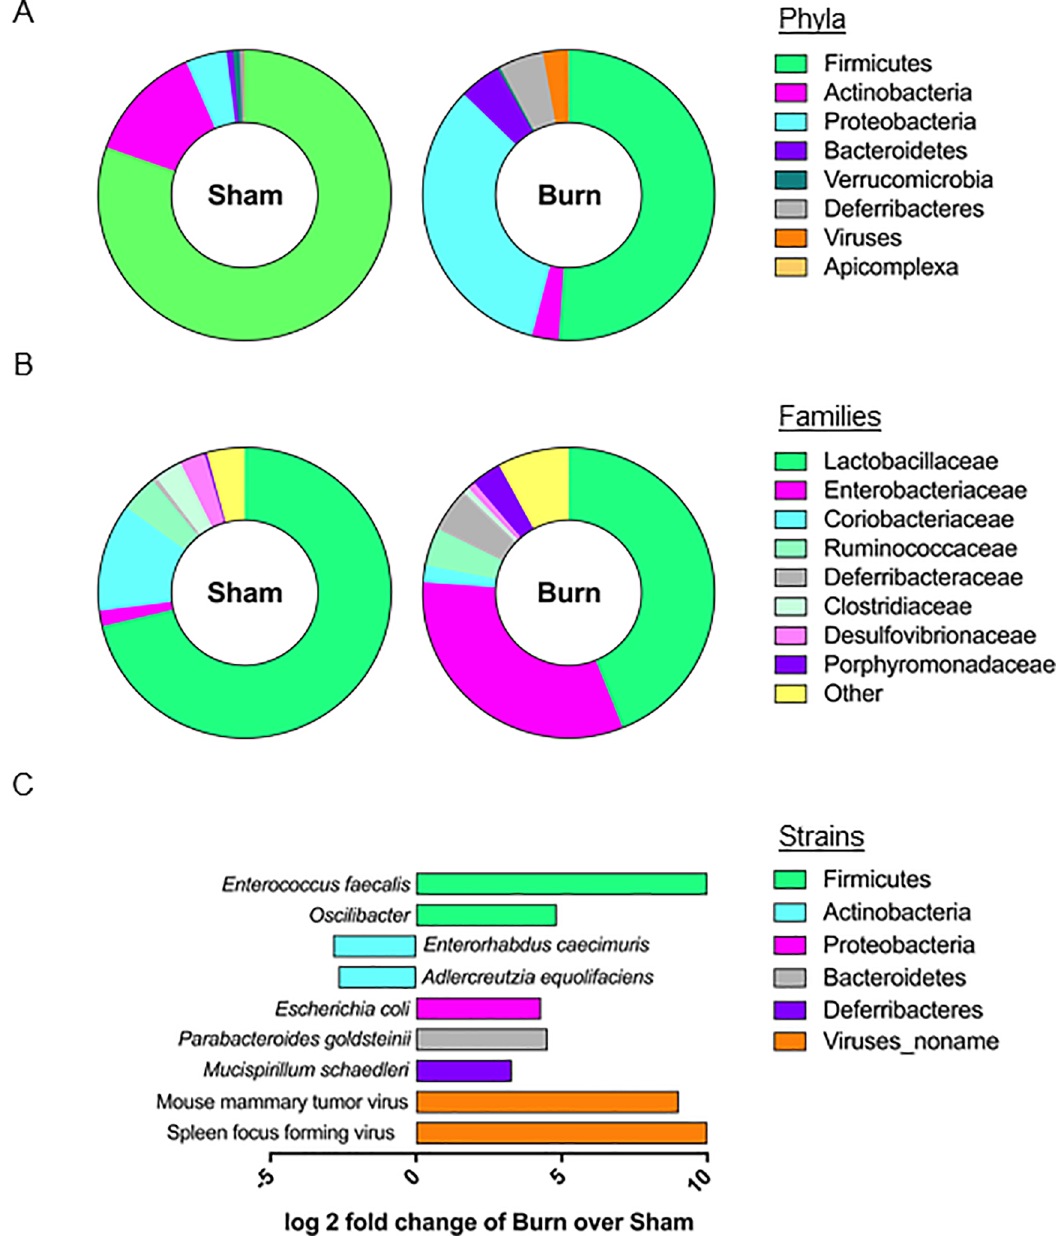
Fig 3. Taxonomic composition of the microbiome is altered upon burn injury. Sunburst plots show the most abundant taxa at the phylum ( A ) and family ( B ) level in the cecum (data shown as means). Differentially abundant strains ( C ) were considered significant if their FDR-corrected p-value was less than or equal to 0.05 and the absolute value of the log-2 fold change was greater or equal to 1. Points at either end of the x-axis indicate infinite log-2 fold change (the other groups mean abundance is 0). 59 strains were tested and only the 9 significantly different strains are